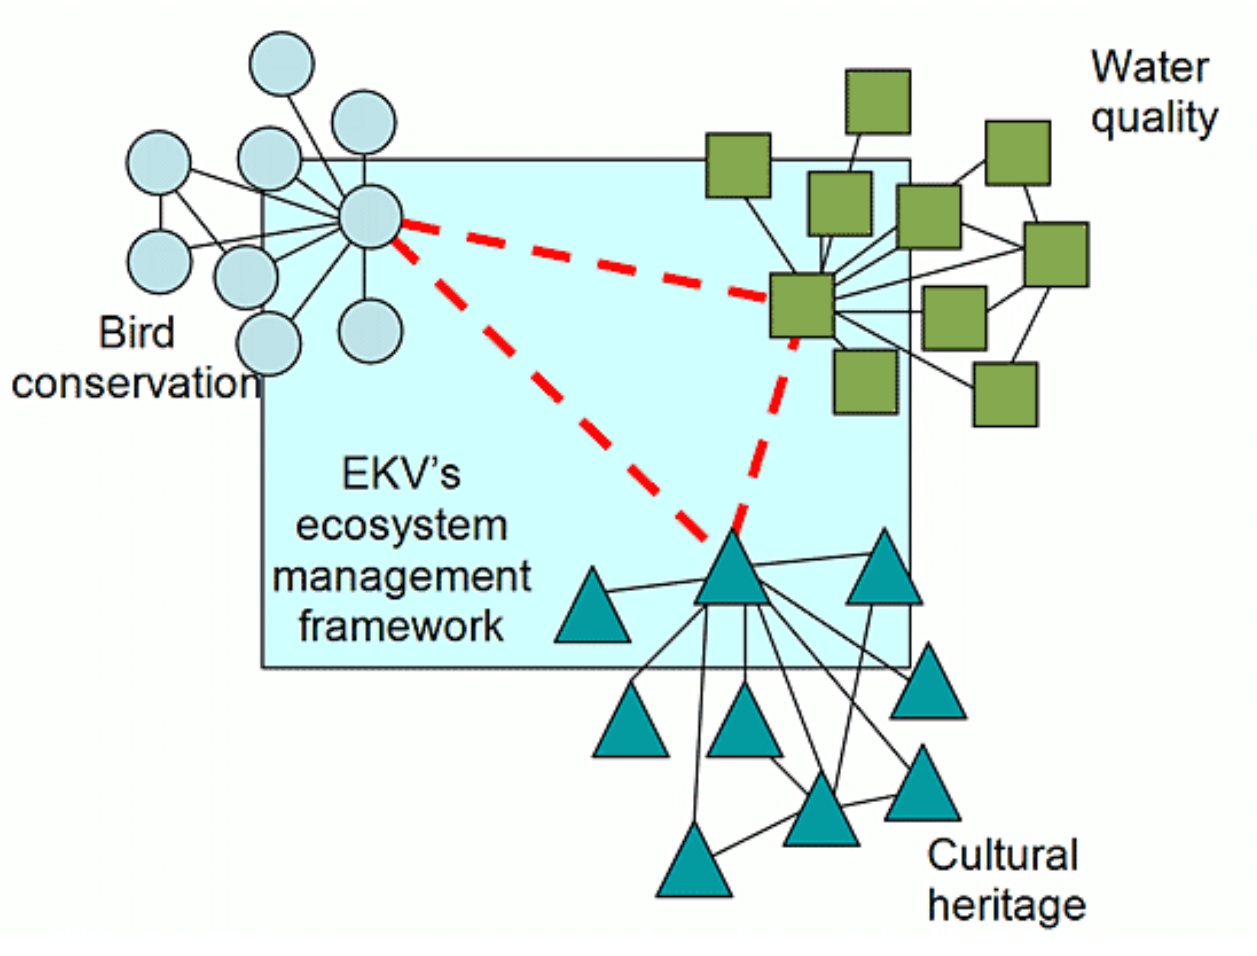
Fig. 5 . Social network of different resource users of Kristianstads Vattenrike (P. Olsson, L. Schultz, C. Folke, and T. Hahn, unpublished manuscript ). EKV stands for Ecomuseum Kristianstads